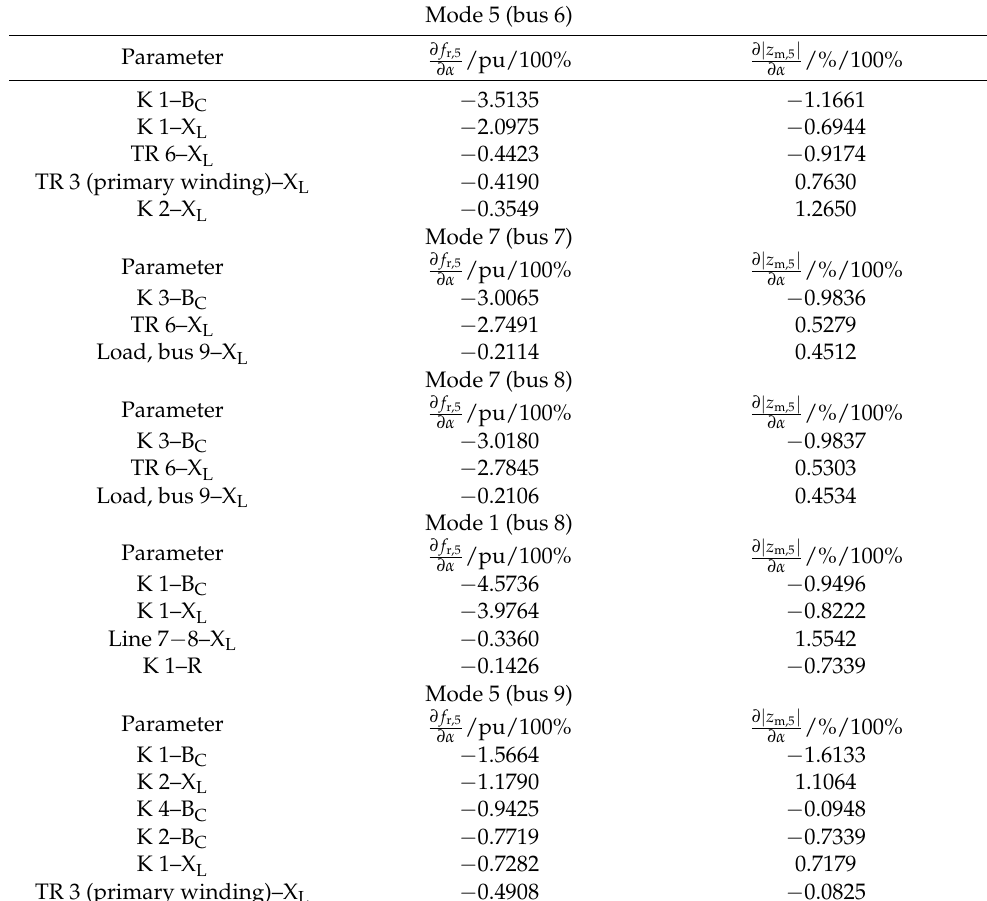
Table 4. Table 4. Series resonance sensitivity coefficients for relevant modes and